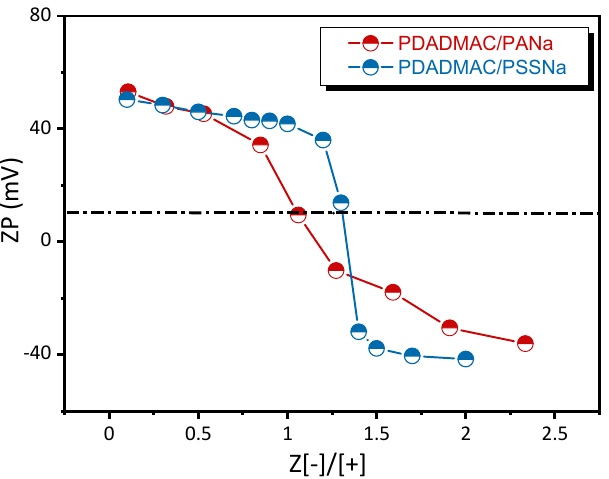
Figure 4. Zeta potential ( ζ ) of PECs prepared at various charge ratios (Z): PDADMAC/PANa and PDADMAC/PSSNa. PECs were prepared from PE solutions at 18.6 mM, pH 10 without added salt.